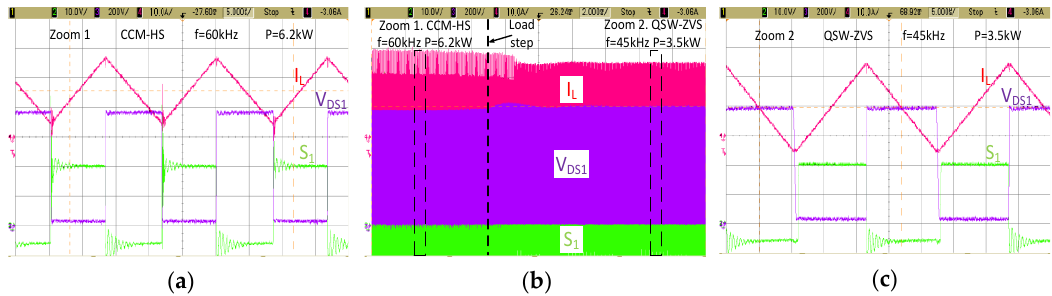
Figure 15. Experimental results showing the change from CCM-HS to QSW-ZVS after a load step (6.2 kW to 3.5 kW) by detecting I Lavg < I L,1 . ( a ) Zoom of CCM-HS operation, ( b ) general view and ( c ) zoom of QSW-ZVS operation. V DS1 (violet), I L (pink) and S 1 (green).